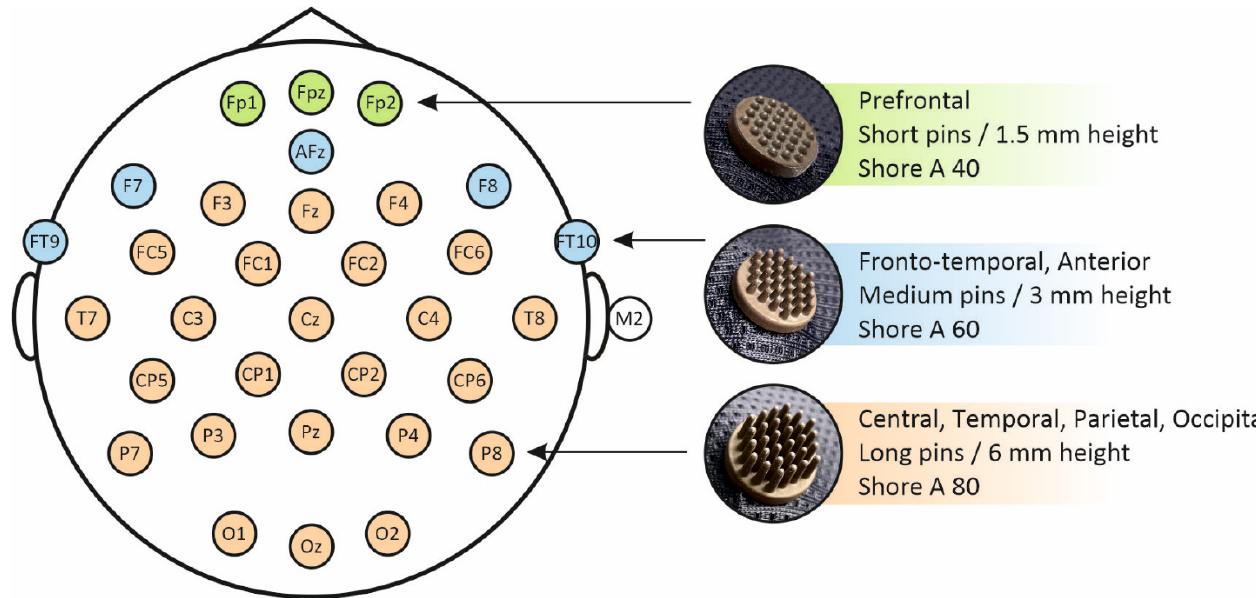
Figure 1. The 32-channel layout of the soft, multipin, dry EEG system, indicating the location and shore hardness of short pins (green), medium pins (blue), and long pins (orange).